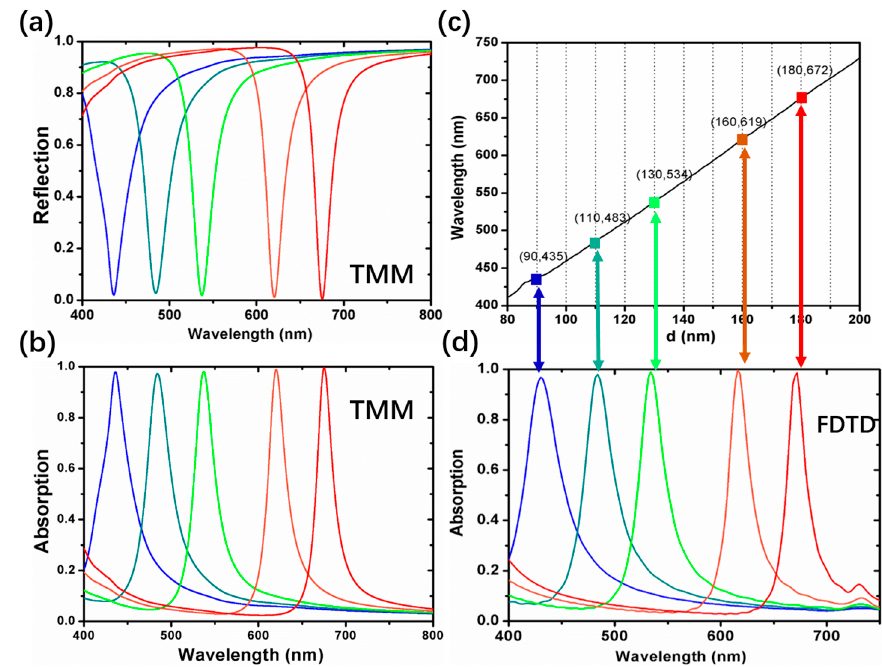
Figure 2. ( a , b ) The calculated reflection and absorption of five SiO 2 thickness d (90, 110, 130, 160, and 180 nm) by the TMM algorithm. ( c ) The relationship of resonance wavelength and the SiO 2 thickness d calculated by the TMM algorithm; ( d ) The five colorful solid lines represent the simulated absorption spectra by the FDTD algorithm when the thickness of the SiO 2 d are 90, 110, 130, 160, and 180 nm, respectively.